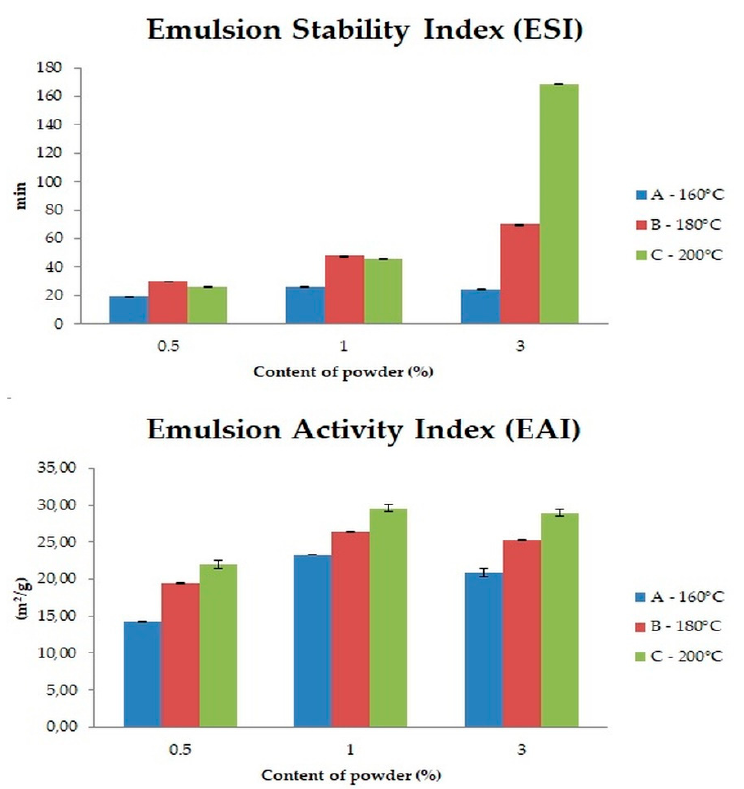
Figure 3. Emulsion Stability Index (ESI) and Emulsion Activity Index (EAI) of emulsions prepared with various content of FOCE powders; A—emulsions prepared with powder obtained at 160 °C; B—emulsions prepared with powder obtained at 180 °C; C—emulsions prepared with powder obtained at 200 °C; and 0.5%, 1%, and 3% are powder contents.